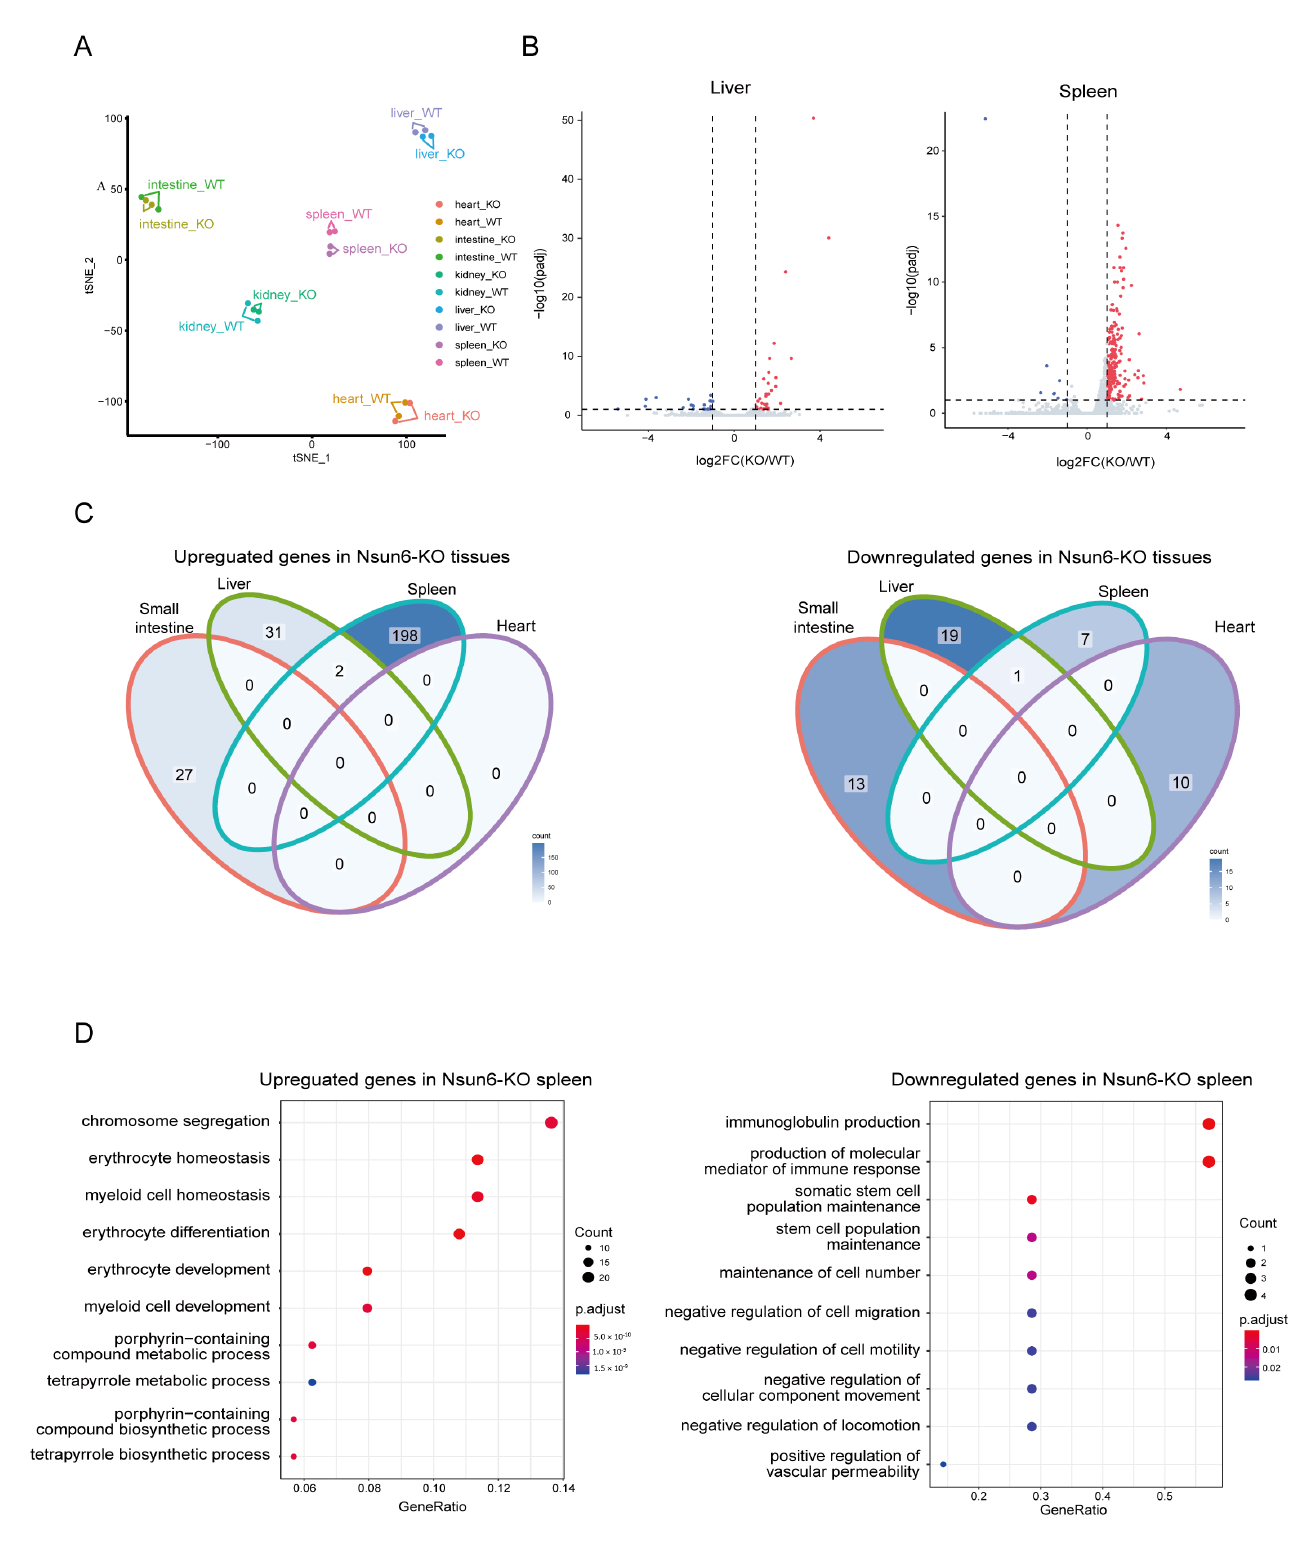
Figure 3. The influence of Nsun6 KO on transcriptome across tissues. ( A ) A t-SNE plot presenting the transcriptomic similarity and divergence of all RNA-seq data sets. ( B ) Volcano plots presenting the DEGs identified in the liver and spleen of KO mice. ( C ) A Venn diagram of the DEGs in Nsun6-KO small intestine, liver, spleen, and heart. ( D ) GO analysis of the DEGs in Nsun6-KO